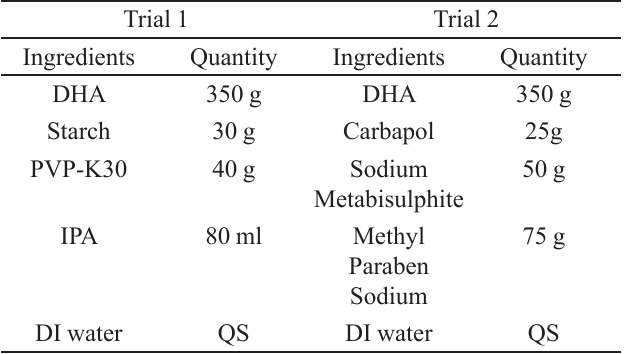
TABLE I - Formulation of DHA